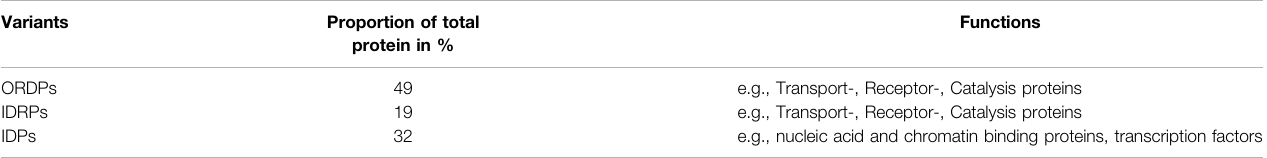
TABLE 1 | Overview of the type, proportion, and function of intrinsically disordered protein s in the cell.